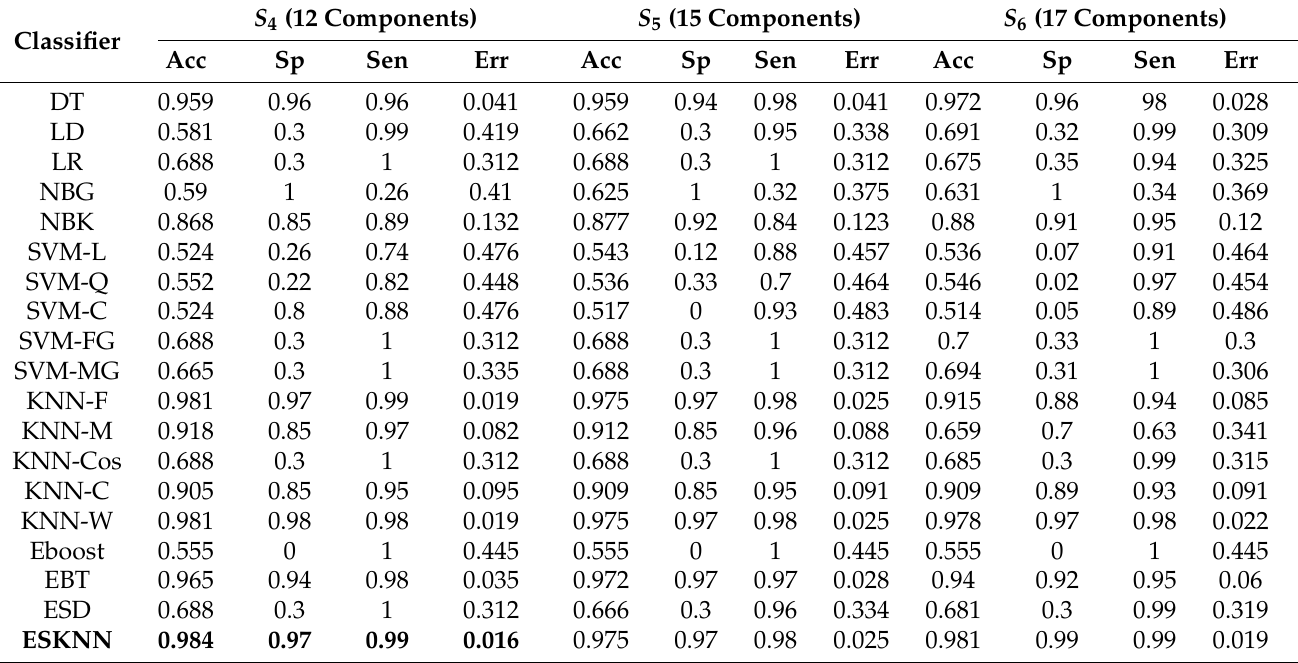
Table 10. Consolidated result analysis of feature sets ( S 4 , S 5 , S 6 ) for method I with various classifiers. Bold font indicates best